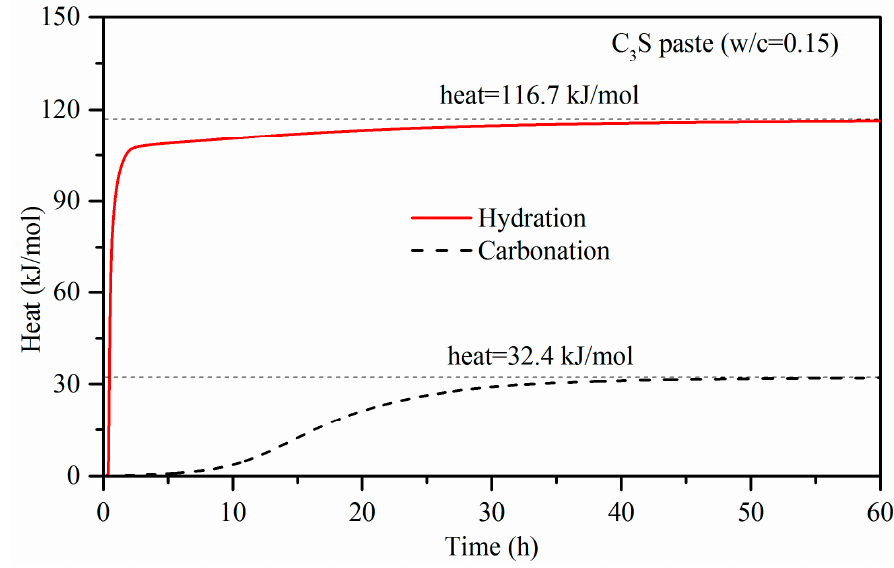
Figure 6. Heat of carbonation and hydration versus time.